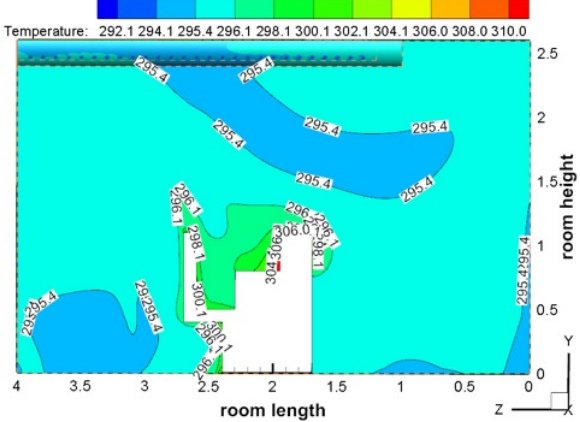
Figure 10. The temperature distribution of the Y = 0.6 m section.